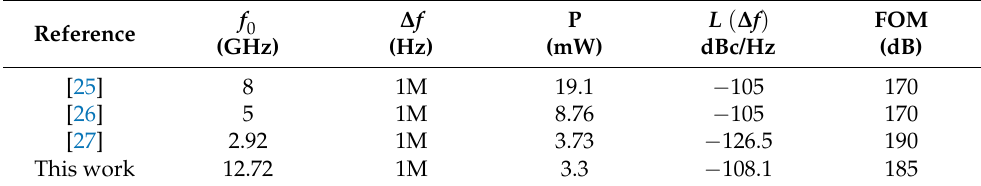
Table 1. Comparison results of VCO’s Figure of Merit